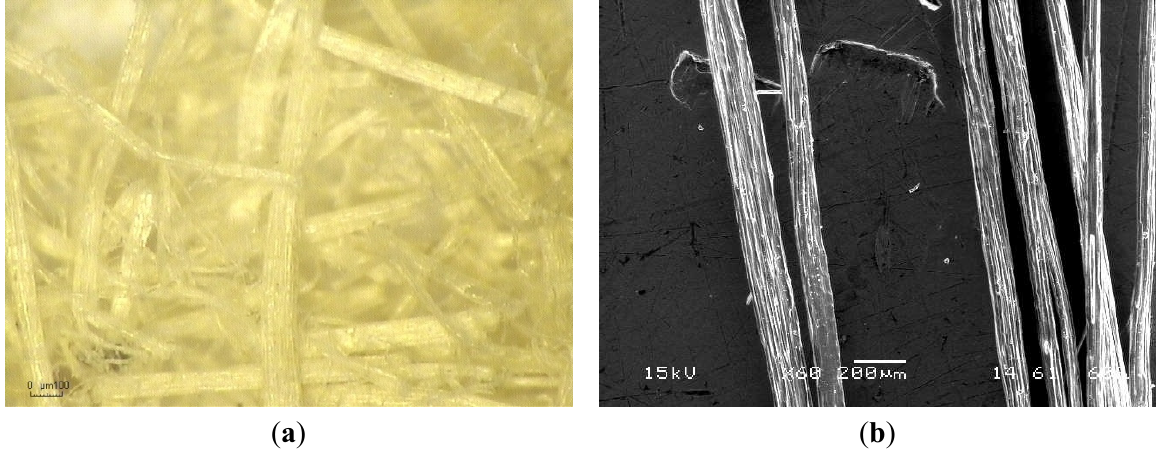
Figure 6. Video microscope image ( a ) ×175 and SEM micrograph ( b ) ×60 of the